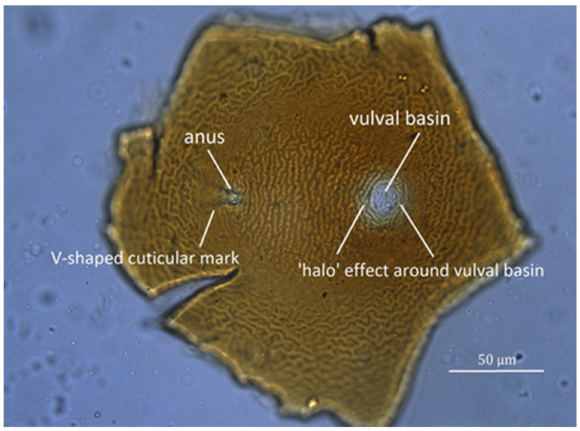
Figure 7. Light microscope image of cuticle surface of perineal region of potato cyst nematode (PCN) ( G. rostochiensis ) cyst laid flat on glass microscope slide.